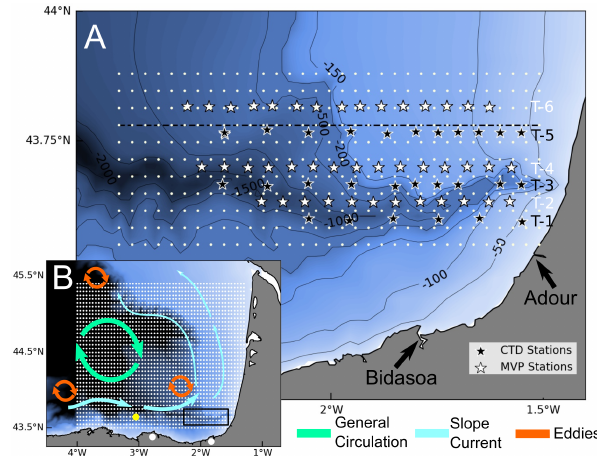
Figure 1. Sampling map and circulation in the Bay of Biscay. Lo- cation of the conductivity–temperature–depth (CTD) and moving vessel profiler (MVP) stations (a) . At uneven transects (T-1, T-3, and T-5), black stars mark the CTD stations where vertical casts of temperature, salinity, and in vivo multi-spectral chlorophyll a (chl a ) fluorescence were collected. At even transects, white stars mark the location of the point at which MVP data have been av- eraged, located every 5km. White dots represent the grid at which these measurements were interpolated, and the dashed black line marks the cross section at 43.77 ◦ N analysed in Figs. 5 and 7. The locations of the Adour and Bidasoa rivers are shown by the black arrows. Seasonal to mesoscale circulation in the Bay of Biscay (b) . The small white dots represent the HF radar grid, the yellow dot corresponds to the location of the oceano-meteorological buoy used for the wind data, and large white dots mark the location of the HF radar antennas. The black rectangle shows the area covered by the in situ sampling during ETOILE survey, which is zoomed in (a)